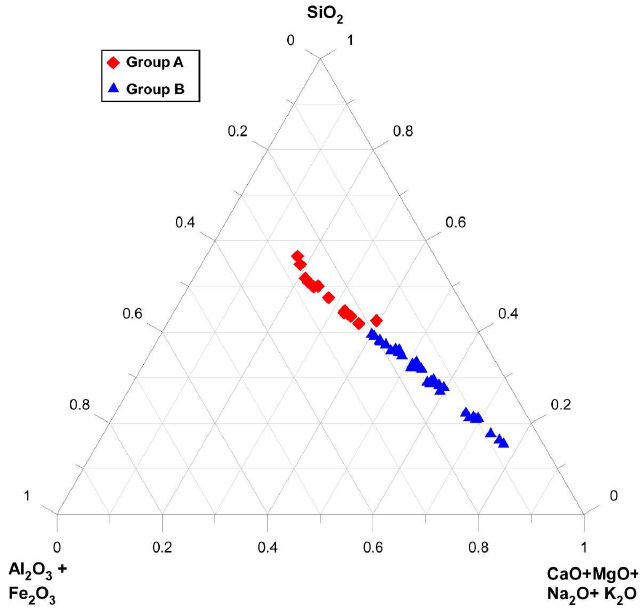
Figure 6. Ternary diagram of the oxide in the bottom sediments of Sharm Al-Kharrar.